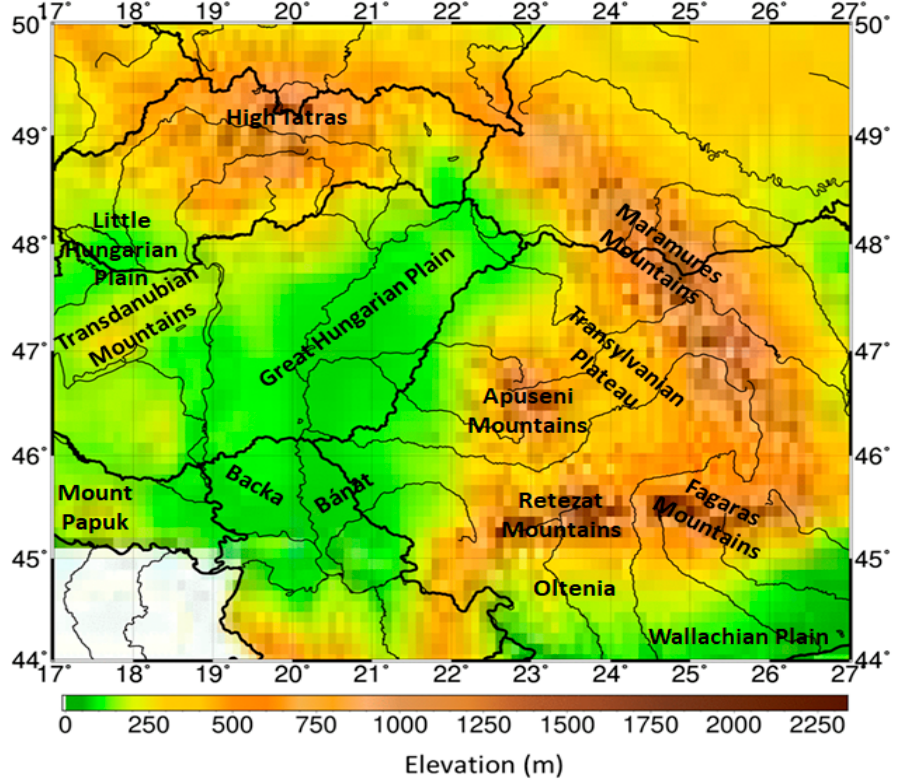
Figure 1. The region studied. Geographical designations used in the study and the basic elevation data are also denoted.